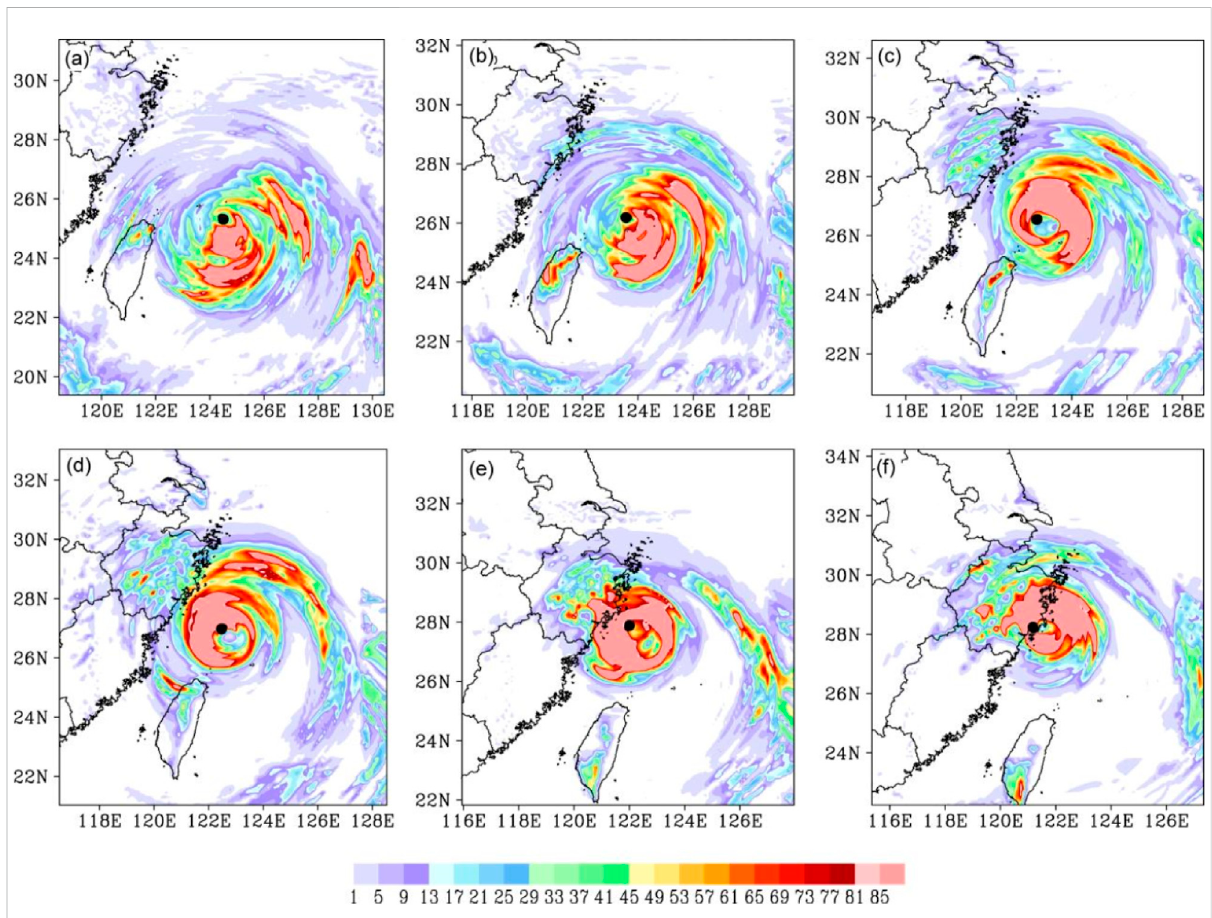
FIGURE 6 Simulated 6 h accumulated precipitation (unit: mm) at (A) 18:00 UTC on 8 August, (B) 00:00 UTC on 9 August, (C) 06:00 UTC on 9 August, (D) 12:00 UTC on 9 August, (E) 18:00 UTC on 9 August, and (F) 00:00 UTC on 10 August 2019 in the PBL1 experiment. The black dots indicating the center of